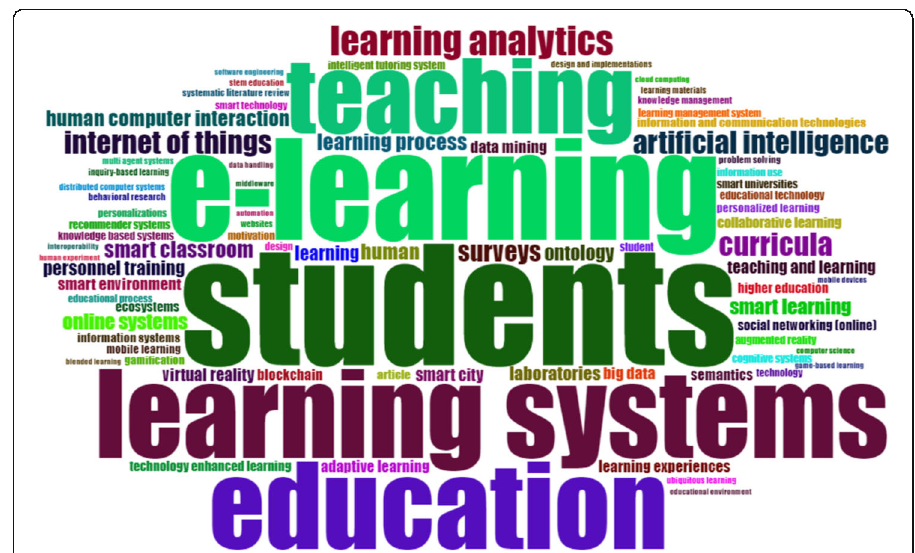
Fig. 8 A Visualized Word-cloud of frequently used keywords in the smart learning environment field: these are among the highest number of repetitive keywords within the field